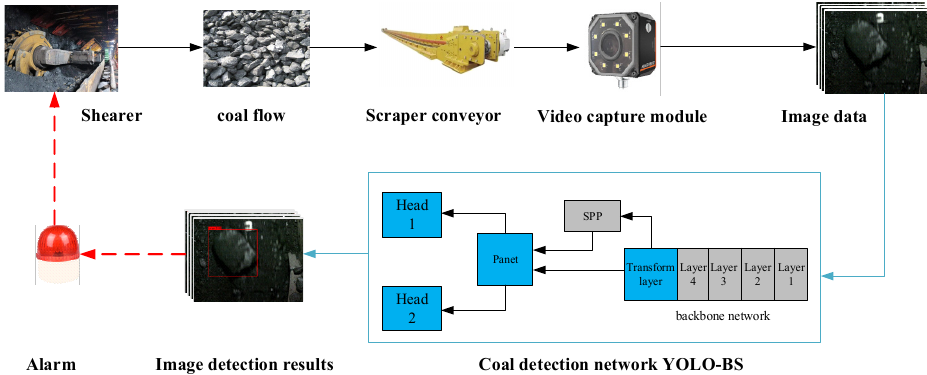
Figure 2. Technical route of coal monitoring